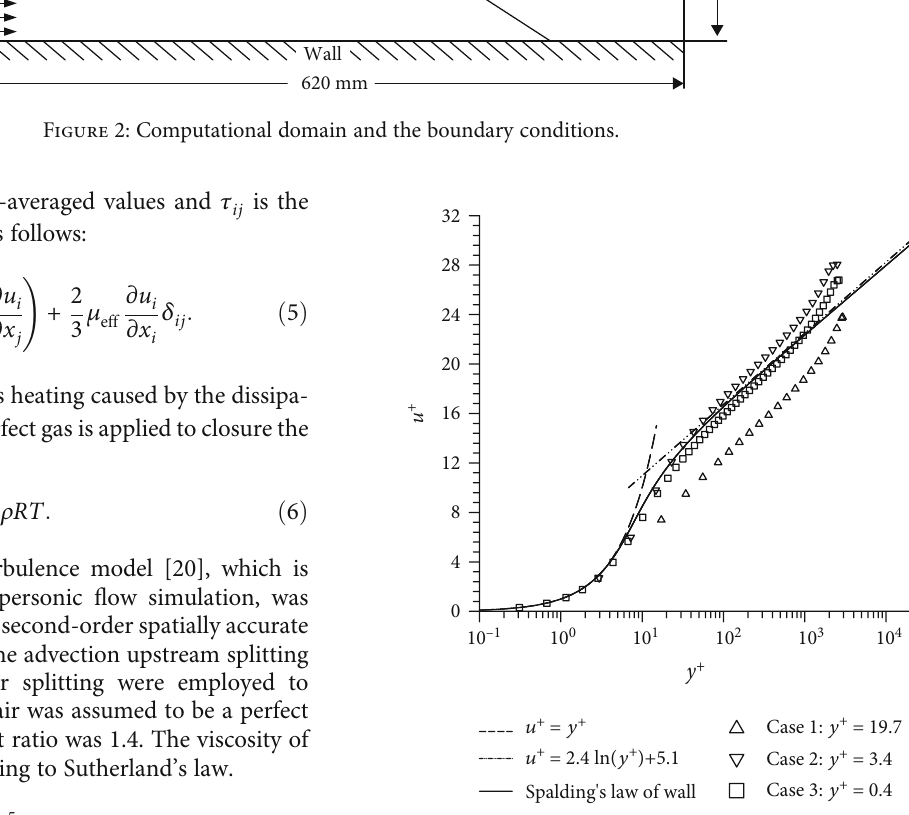
Figure 3: Comparison of simulated velocity pro fi les with Spalding ’ s law of